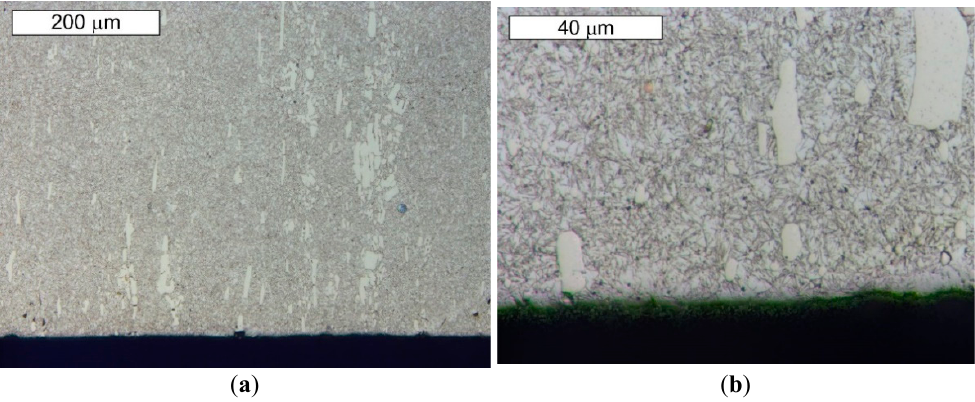
Figure 15. Material microstructure in the wear area of sample 2: ( a ) visible small spallings in the primary carbide area; ( b ) magnified fragment of the area from Figure 15a. Cross-section. Light microscopy, etched state.